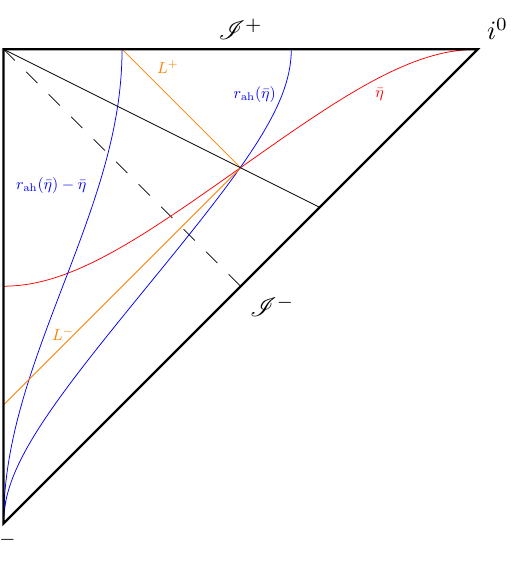
(¯ η ) and the area of the ah